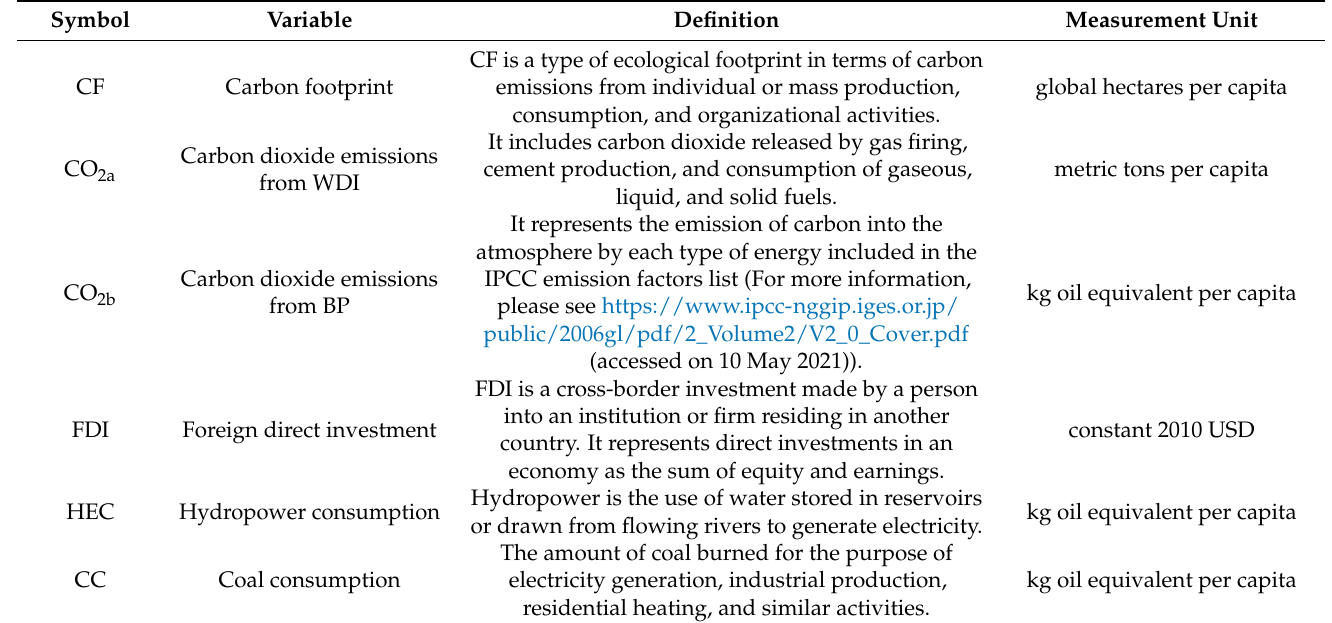
Table 2. The definitions of variables